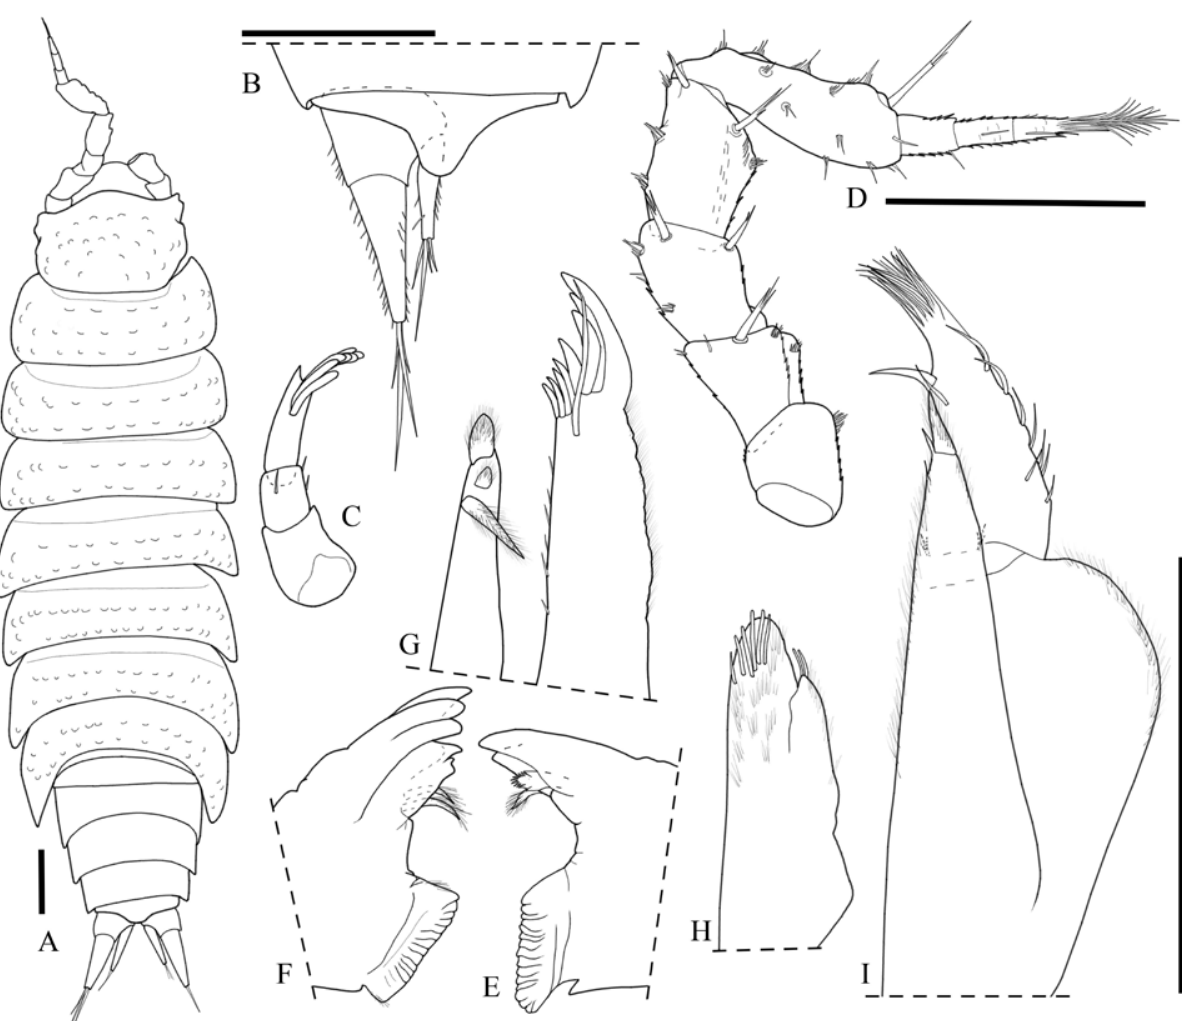
Figure 1. Pectenoniscus montalvaniensis n. sp. Male paratype: A , habitus, dorsal view; B , pleotelson and uropod, dorsal view; C , antennula; D , antenna; E , left mandible; F , right mandible; G , maxillula; H , maxilla; I , maxilliped. Scale bars: 0.2 mm.